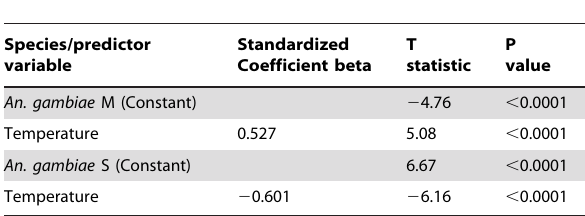
Table 2. Multiple regression model for environmental variable predicting the presence of the An. gambiae M and S forms.